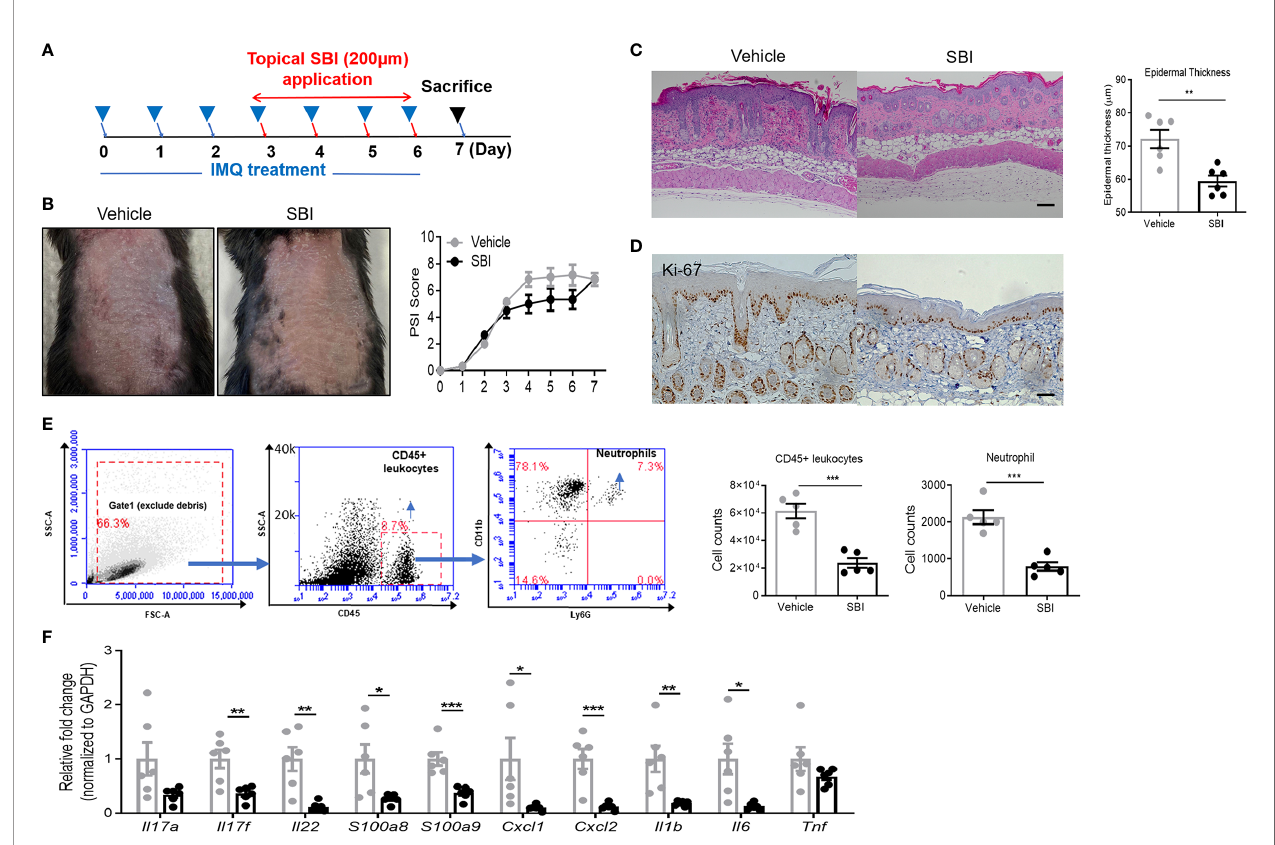
FIGURE 3 | Topical application of SBI therapeutically improves PsD with inhibited in fi ltration of neutrophils. (A) Schematic illustration of experimental protocols. (B) Manifestations and the severity of skin in fl ammation measured by PSI score in mice treated as shown in (A) . (C) HE staining and histological analysis of epidermis thickness. (D) Ki-67 staining examined by immunohistochemistry staining. (E) Flow cytometry plots showing gating strategy. Absolute number of in fi ltrating CD45+ cells and neutrophils examined by fl ow cytometry. (F) mRNA expression of cytokines in the whole ear. 6 animals per group. Scale bars, 50 m m. Data are presented as mean ± SEM. *p < 0.05; **p < 0.01; ***p <